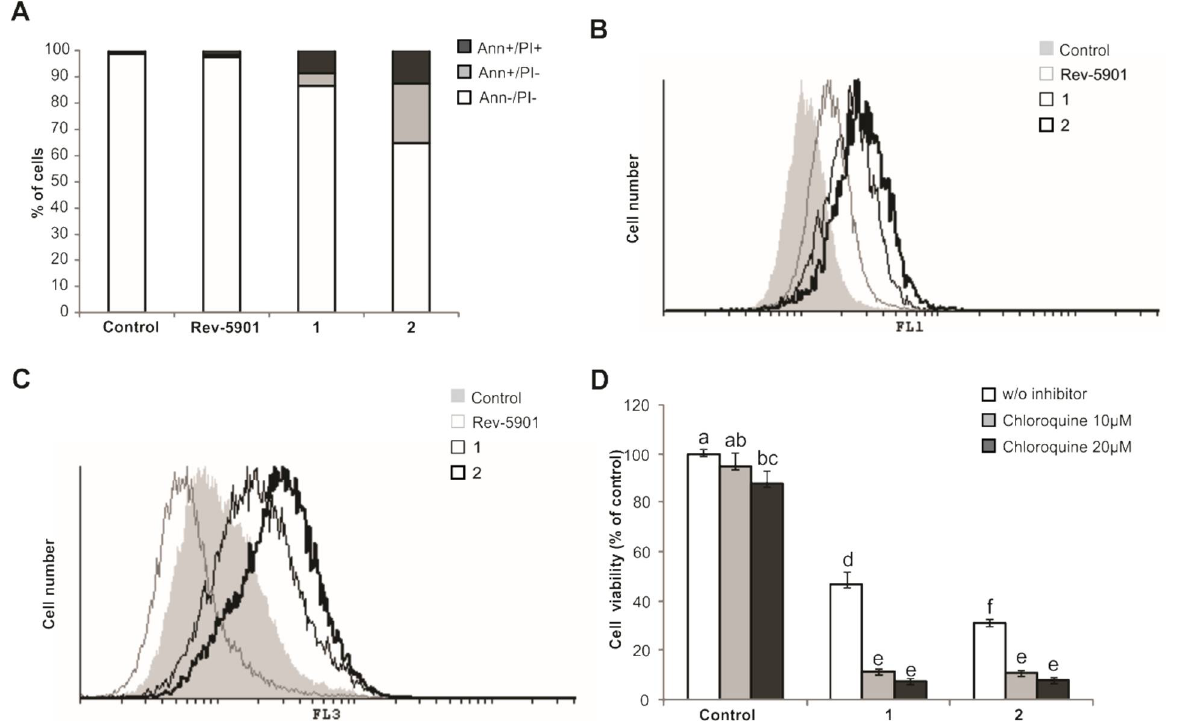
Figure 1. Treatment with compounds 1 and 2 leads to apoptosis, activation of caspases and induction of autophagy. Colon cancer cells were treated with tested compounds for 24 h with IC 50 doses and stained with Annexin/propidium iodide ( A ), Apostat ( B ) or acridine orange ( C ). Cells were analyzed by flow cytometry. One representative experiment out of three is shown. ( D ) Treatment in the presence or absence of the autophagy inhibitor chloroquine (10 μM and 20 μM) and crystal violet test. Bars not sharing a common letter are significantly different, p < 0.05. FL1 and FL3 are channels for detection of green and red fluorescence, respectively.